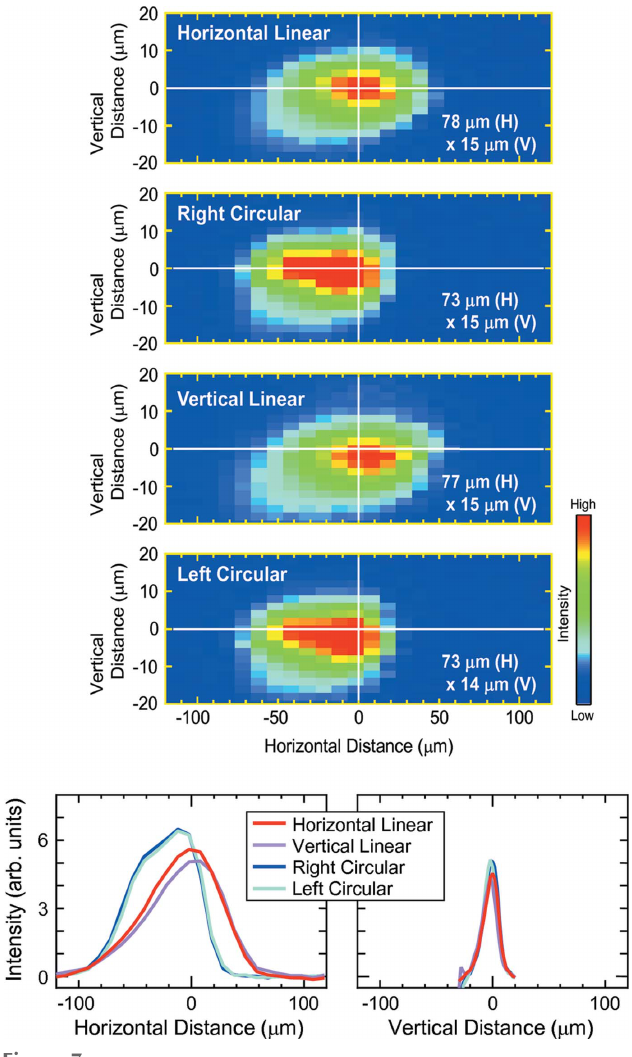
Figure 7 Light polarization dependence of the beam profiles (seen from the upstream side). The photon energy and the exit slit were set to 100 eV (300 lines mm (cid:2) 1 VLSG) and 30 m m, respectively. The measurements were performed in the order of the horizontal-linear polarization, right- circular polarization, vertical-linear polarization, and left-circular polar- ization. Integrated intensities along the vertical and horizontal axes are shown at the bottom. The origin of the vertical and horizontal axes corresponds to the maximum intensity in the integrated intensity curves of the beam with horizontal linear